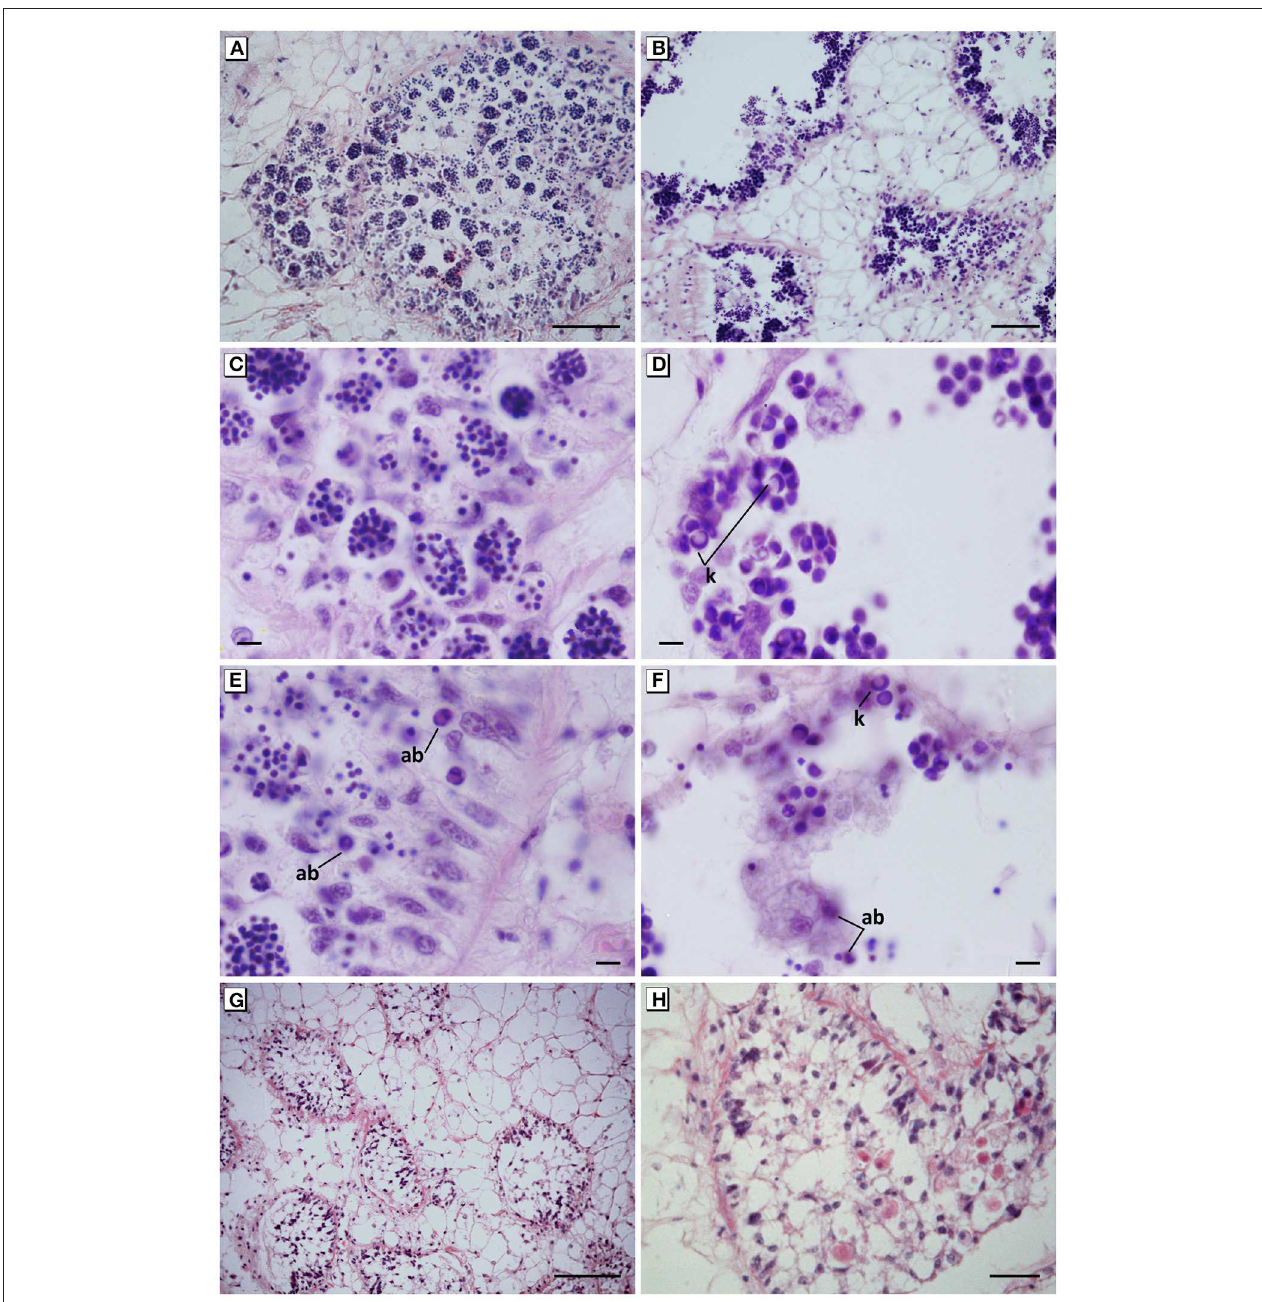
FIGURE 5 | Maturation arrest of the germinal cells and spermatogenesis failure. (A,C) Disorganisation of the germinal epithelium and abnormal aggregates of hyperchromatic spermatids in mussels exposed to 40mg L − 1 for 17 days. (B,D) Disorganisation of the germinal epithelium and abnormal aggregates of apoptotic spermatocytes showing karyorrhexis in mussels exposed to 60mg L − 1 for 10 days. (E) Hypertrophy and hyperplasia of auxiliary cells (Sertoli-like cells) with an intense phagocytic activity of apoptotic spermatids in mussels exposed to 40mg L − 1 tar for 17 days. (F) Auxiliary cells in the lumen follicular engulfing apoptotic spermatocytes in mussels exposed to 60mg L − 1 for 10 days. (G,H) Hyperplasia of pleomorphic and vacuolated auxiliary cells filling the lumen follicular in mussels exposed to 60mg L − 1 for 10 days. In all cases, a total absence of spermatozoa in mussels was evident. Haematoxylin and eosin stain. ab, Apoptotic bodies; k, karyorrhexis. Scale bar: 100 µ m (B,G) , 50 µ m (A) , 25 µ m (H) , 10 µ m (C–F) .